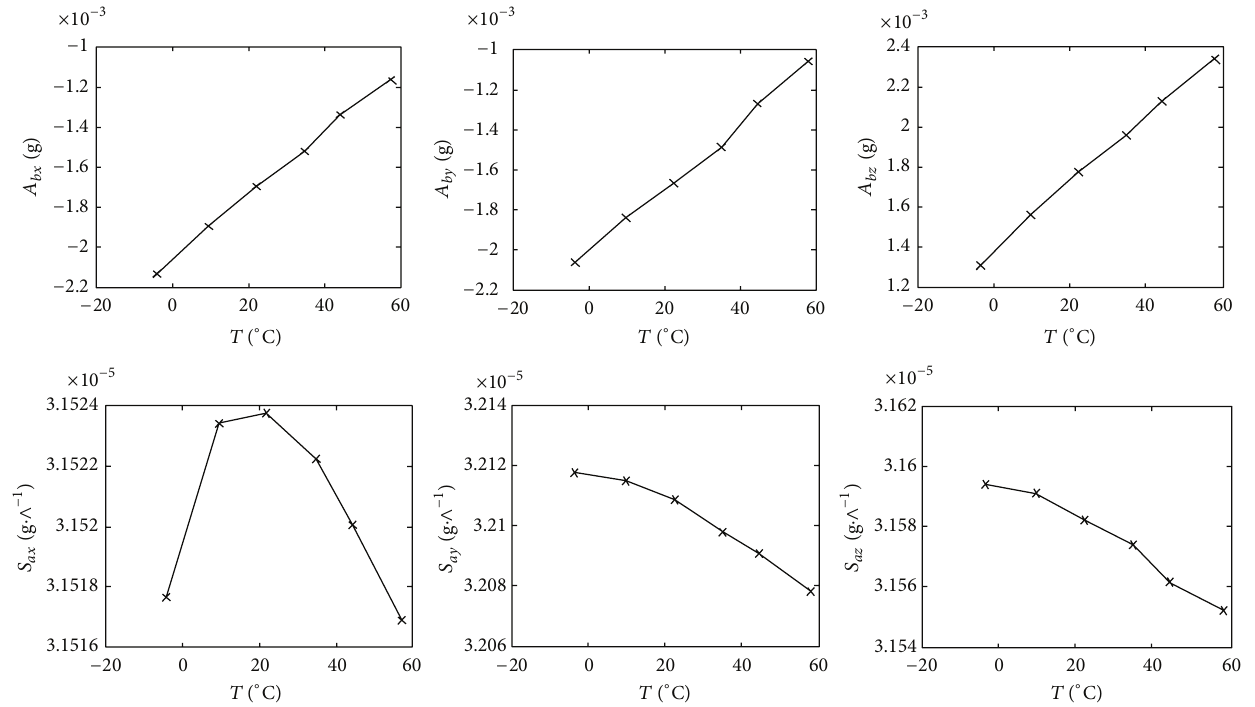
Figure 5: Curves of accelerometer bias and scale factor changing with